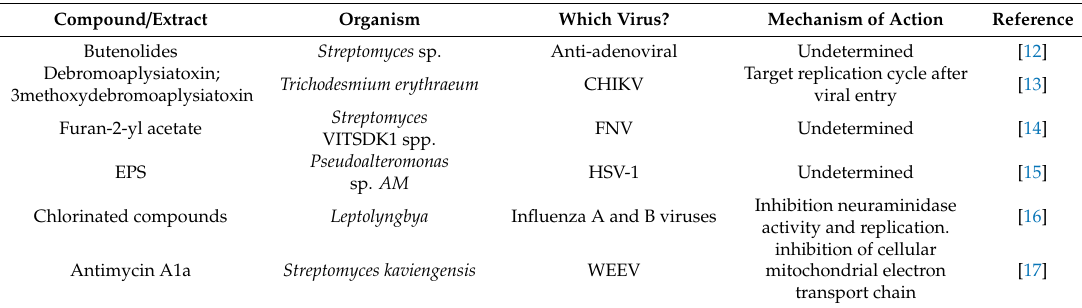
Table 1. The table report antiviral compounds / extracts from marine bacteria. CHIKV, Chikungunya virus; FNV, Fish Nodavirus; HSV-1, Herpes Simplex virus 1; WEEV, Western Equine Encephalitis virus; EPS, exopolysaccharides.